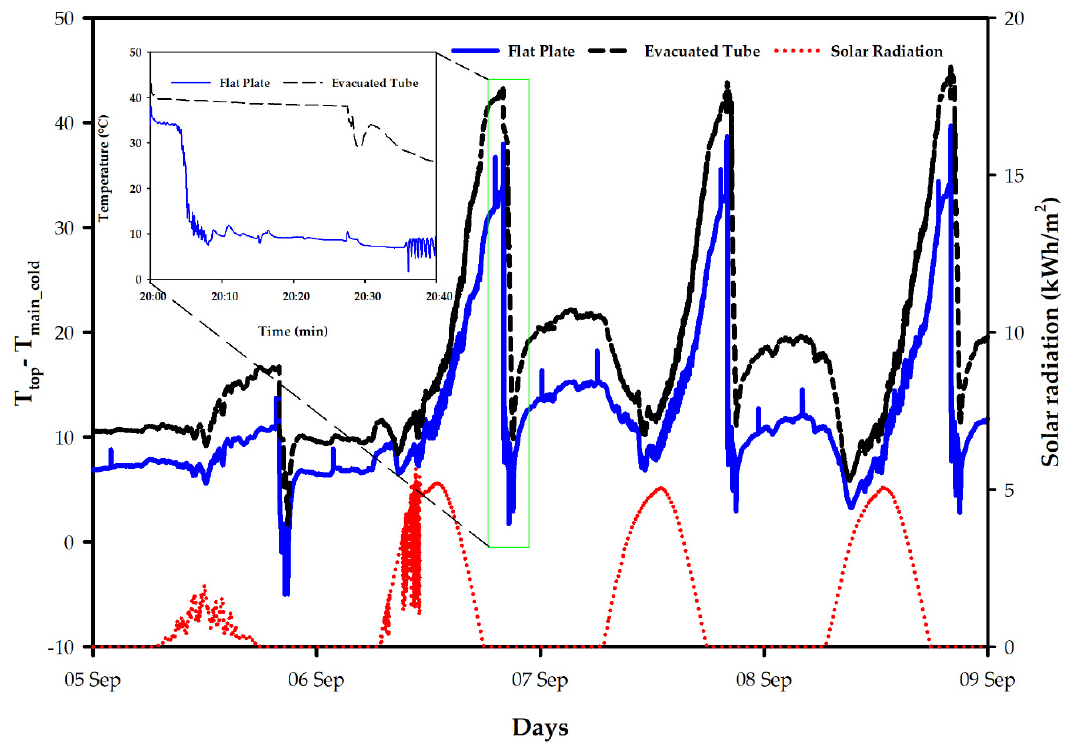
Figure 6. Difference in temperature between cold water from the mains and water produced by the high- and low-pressure solar water heaters.